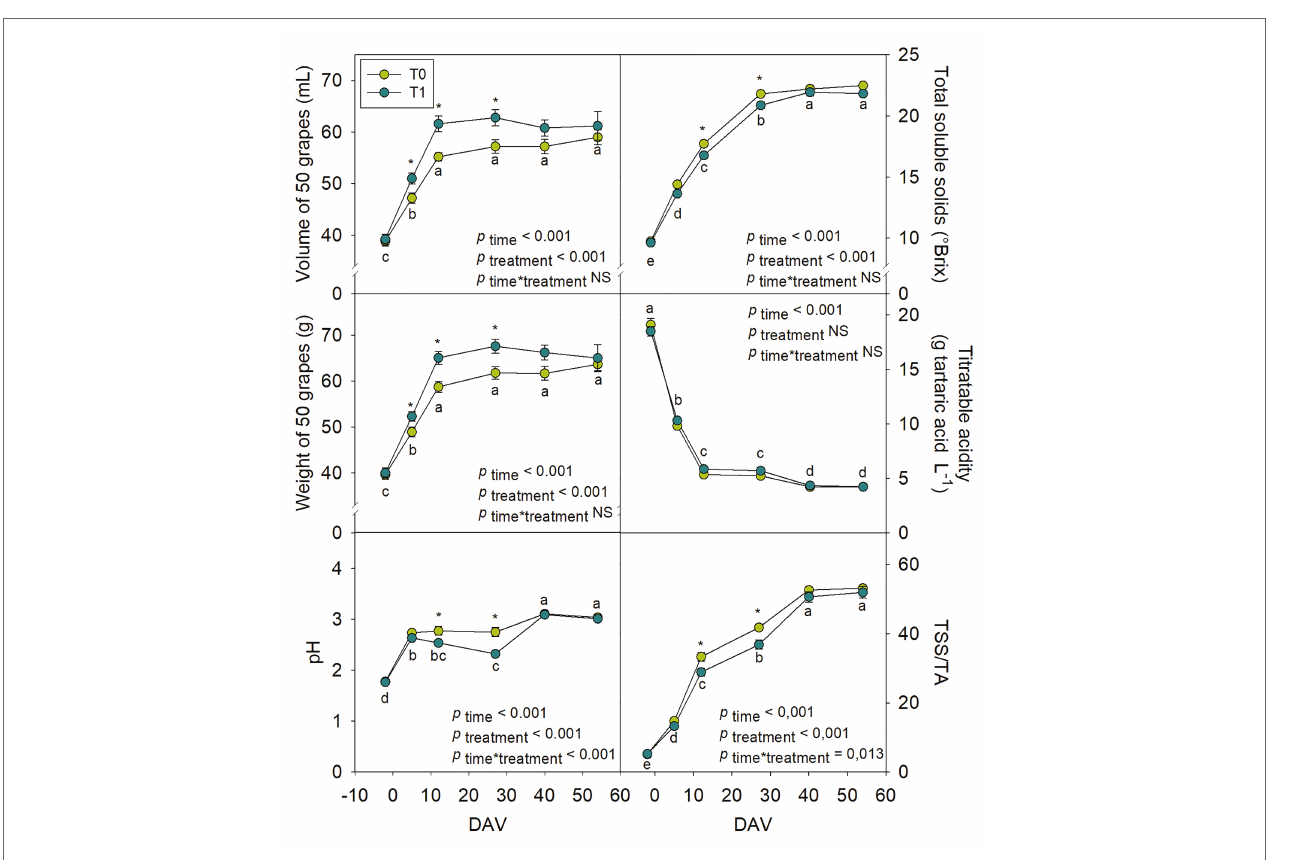
FIGURE 5 | Variations in “Merlot” berry quality characteristics during ripening in non-irrigated (T0) and irrigated (T1) vineyards. Quality parameters measured included grape volume (ml), weight (g fresh matter), pH, total soluble solids (TSS, ° Brix), titratable acidity (TA, g L −1 tartaric acid) and the TSS/TA ratio. Vertical bars indicate SE of 10 replicates, and 50 berries were used from each replicate. Different letters denote significant differences among sampling dates (Tukey’s HSD post-hoc test p < 0.05). The asterisks indicate significant differences between treatments ( p <